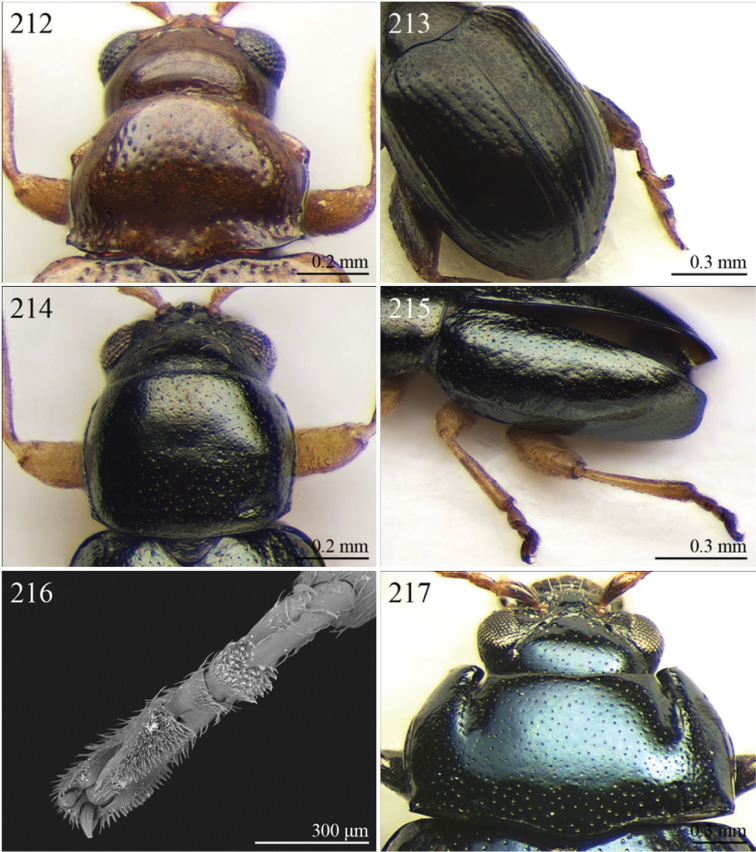
Morphological characters. 212
Manobia africana Laboissière, head and pronotum in dorsal view 213
Metroserrapha sp., hind leg and elytral punctation 214
Montiaphthona gedyei (Bryant), head and pronotum in dorsal view 215 Ditto, elytra in sublateral view 216
Myrcina vandenplaasi Laboissiére, double apical spur of hind tibia 217
Nisotra aruwimiana Weise, head and pronotum in dorsal view.